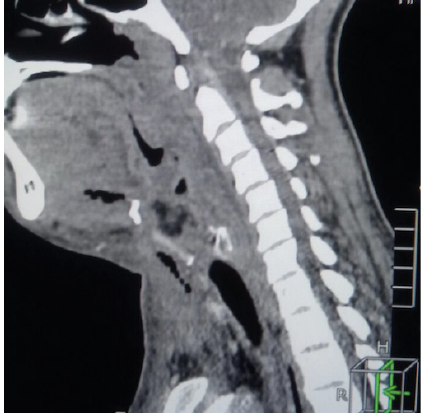
Figure 1. Computed tomography of the neck and thorax in sagittal view showing a purulent collection in the retropharyngeal space and on the deep neck space, compromising the airway.